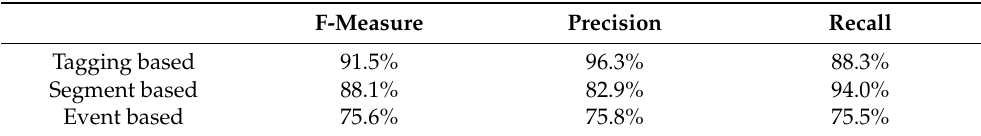
Figure 13. The test procedure compared by prediction output and the ground truth. Table 2. The F1-score, precision and recall values.